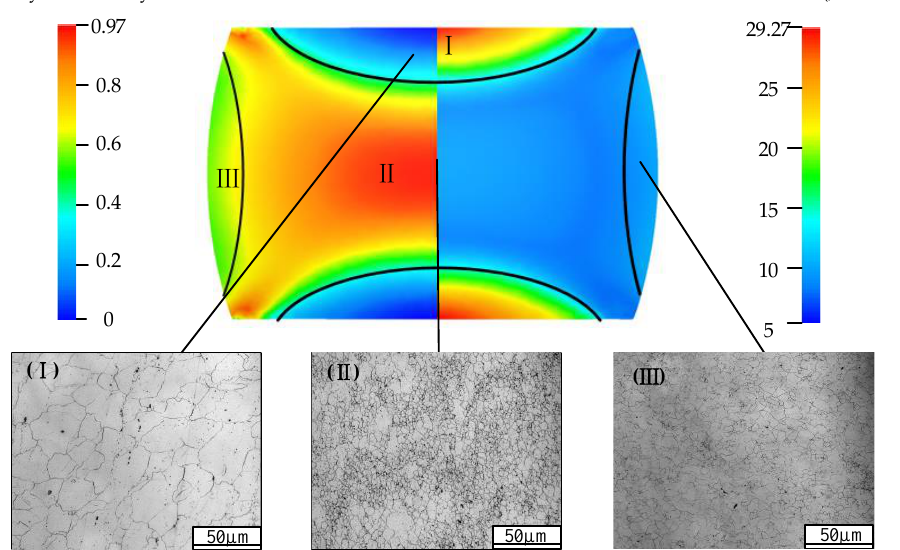
Figure 13. Comparison between simulation results and compression experiment at 1050 °C and 0.1 s −1 : ( I ) difficult deformation region; ( II ) large deformation region; ( III ) small deformation region.